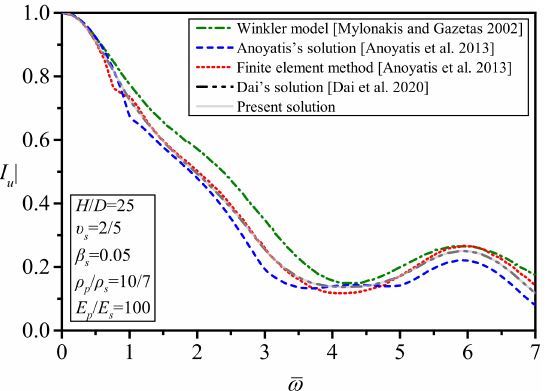
Figure 3. Comparisons of the kinematic response factor between the present solution and that of Mylonakis and Gazetas [18], Anoyatis et al. [20] and Dai et al. [9].